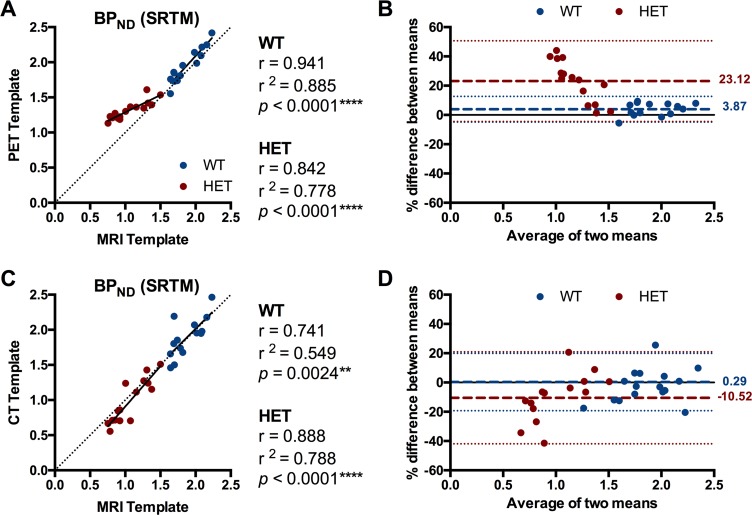
Impact of spatial normalization on [18F]MNI-659 BPND.(A) Correlation between striatal [18F]MNI-659 BPND values obtained from MRI- and PET-based spatial normalizations for WT and HET Q175 mice. The regression line of HET Q175 mice sensibly deviated from the identity line (dotted line) at lower values. (B) Bland Altman plot to compare the MRI- and PET-based approaches of spatial normalizations for [18F]MNI-659. HET Q175 mice were characterized by a relevant deviation between the two approaches, while WT littermates showed high agreement between measurements. (C) Correlation between striatal [18F]MNI-659 BPND values obtained from MRI- and CT-based spatial normalizations for WT and HET Q175 mice. (D) Bland Altman plot to compare the MRI- and CT-based approaches of spatial normalizations for [18F]MNI-659. HET Q175 mice were characterized by a deviation between the two approaches, while WT littermates showed agreement between measurements. Dotted lines represent the 95% limits of agreement (mean difference ± 1.96 x SD of the differences). The bias between the two approaches is represented by the gap between the mean (red and blue dashed lines for HET and WT, respectively) and X axis (solid line). The solid horizontal line indicates y = 0. WT = wild-type, HET = heterozygous.